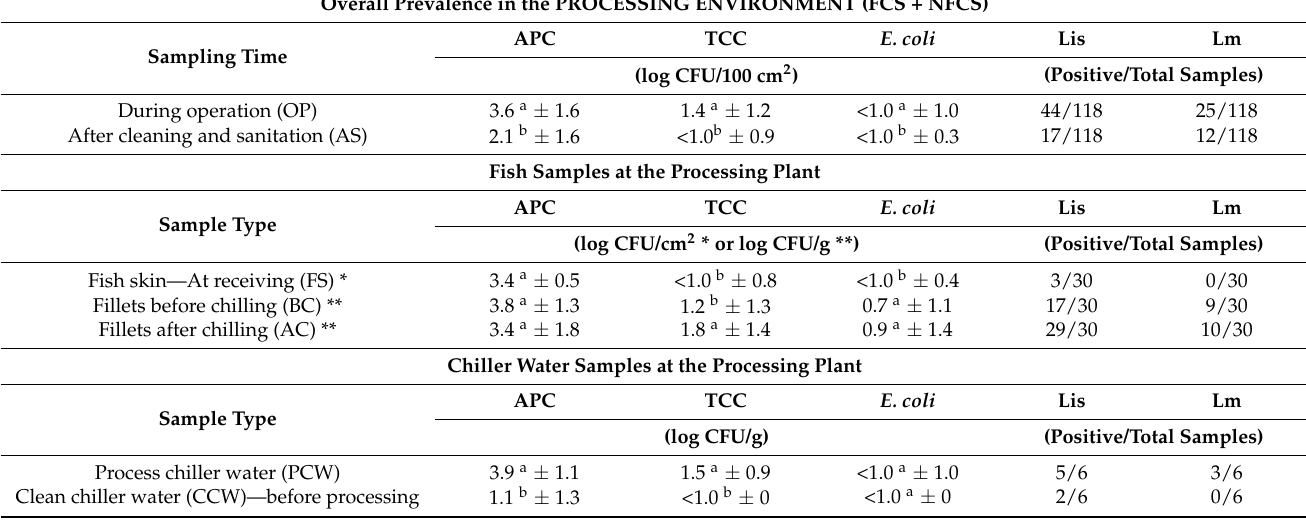
Table 2. Aerobic plate count (APC), total coliform count (TCC), generic E. coli count, Listeria spp. (Lis) and Listeria monocytogenes (Lm) prevalence in the processing environment during operation and after cleaning and sanitation in fish samples and chiller water samples at the processing